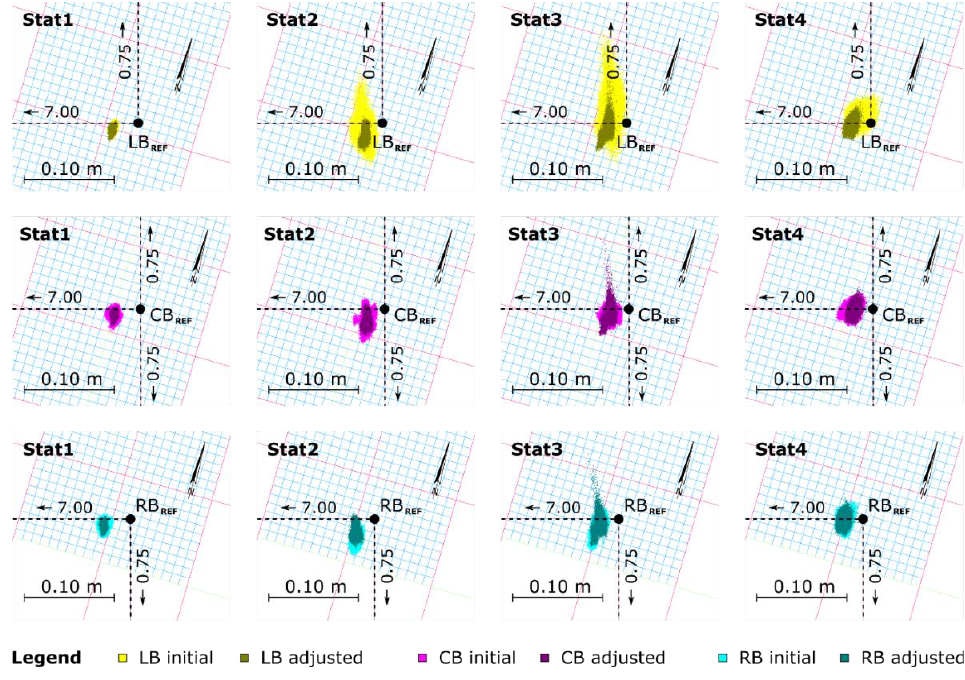
Figure 9. Results of the CLS adjustment of the back-line LB, CB, and RB receivers’ observations. The most precise initial (post-processed) coordinates were obtained in static session Stat1. The least precise results occurred in session Stat3, especially in the case of the LB receiver (top panel of Figure 9). The CLS estimation resulted in a decrease in the subsets’ standard deviation values. Part of the estimates of the coordinates of the frame back-line receivers was significantly affected by the anomalous LB receiver